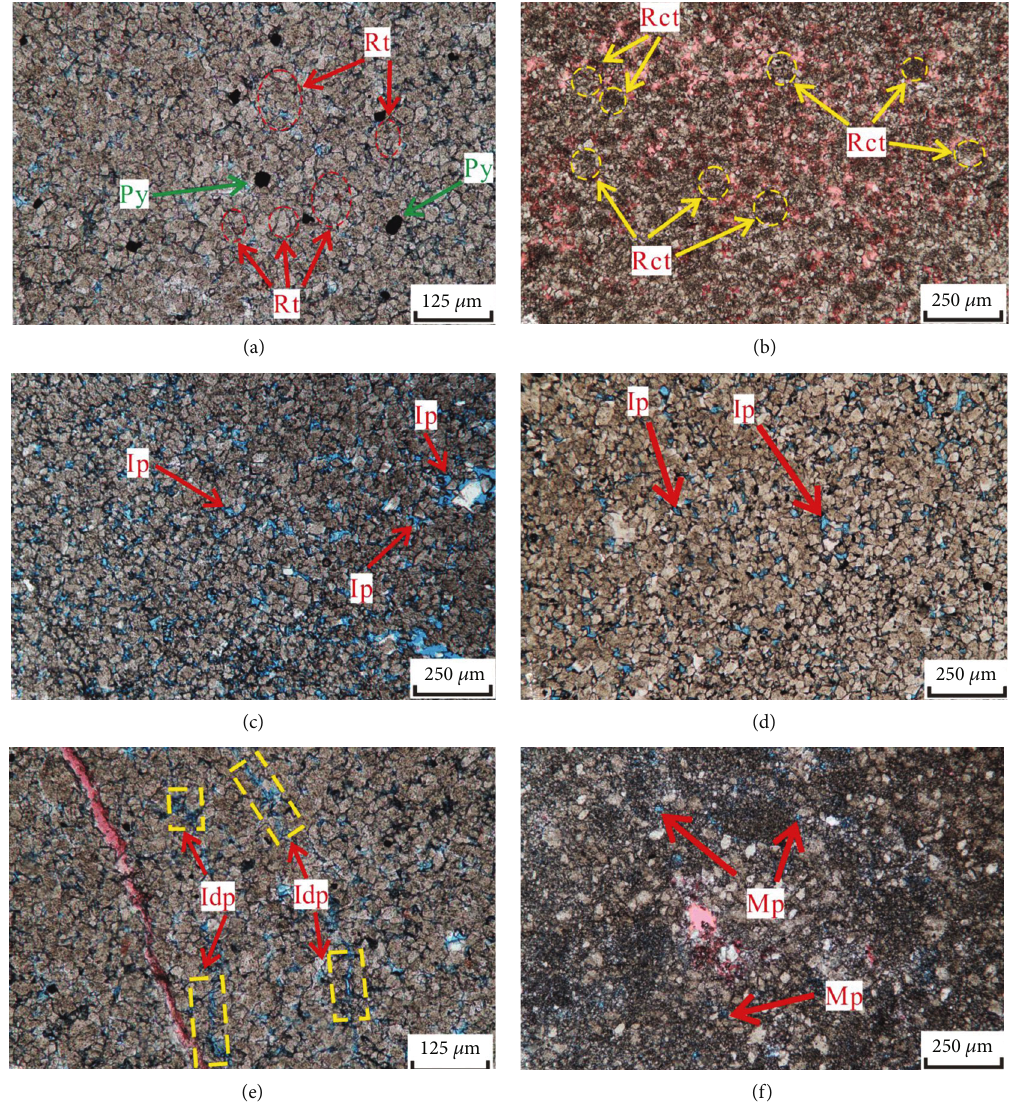
Figure 2: Microphotographs showing the petrographic characteristics of the intercrystalline pore-type dolostone reservoir in the in the western Ordos Basin (IP = intercrystalline pore; Idp = intercrystalline dissolved pore; Mp = micropore; Rt = submember Ma5 5 residual texture; Py = pyrite; Rct = residual chondrum structure). ((a) Powder- fi ne dolostone with oolitic texture, 4040.05m, well Y1117; (b) powder- fi ne calcite-containing dolostone with chondrum structure, 4088.50m, well Y1165; (c) intercrystalline pore, 3710.80m, well S22; (d) intercrystalline pore, 4040.50m, well Y1117; (e) micropore, 3954.80m, well Y1112; (f) intercrystalline dissolved pore, 4040.10m, well